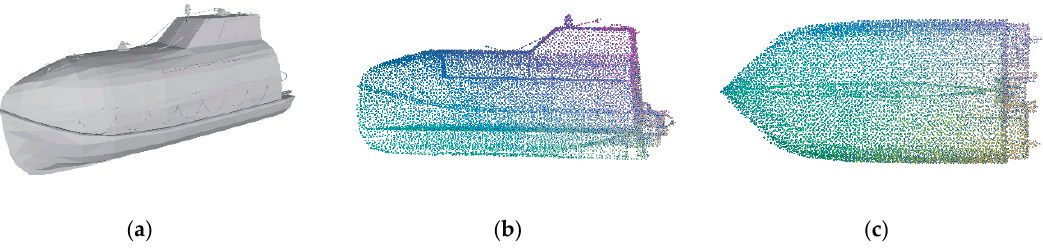
Figure 9. The three-dimensional mesh model of lifeboat ( a ); and the side view ( b ) and top view ( c ) of the boundary particle model involved in the fluid–solid coupling calculation. Single layer nonuniform particle boundary is based on PDS.